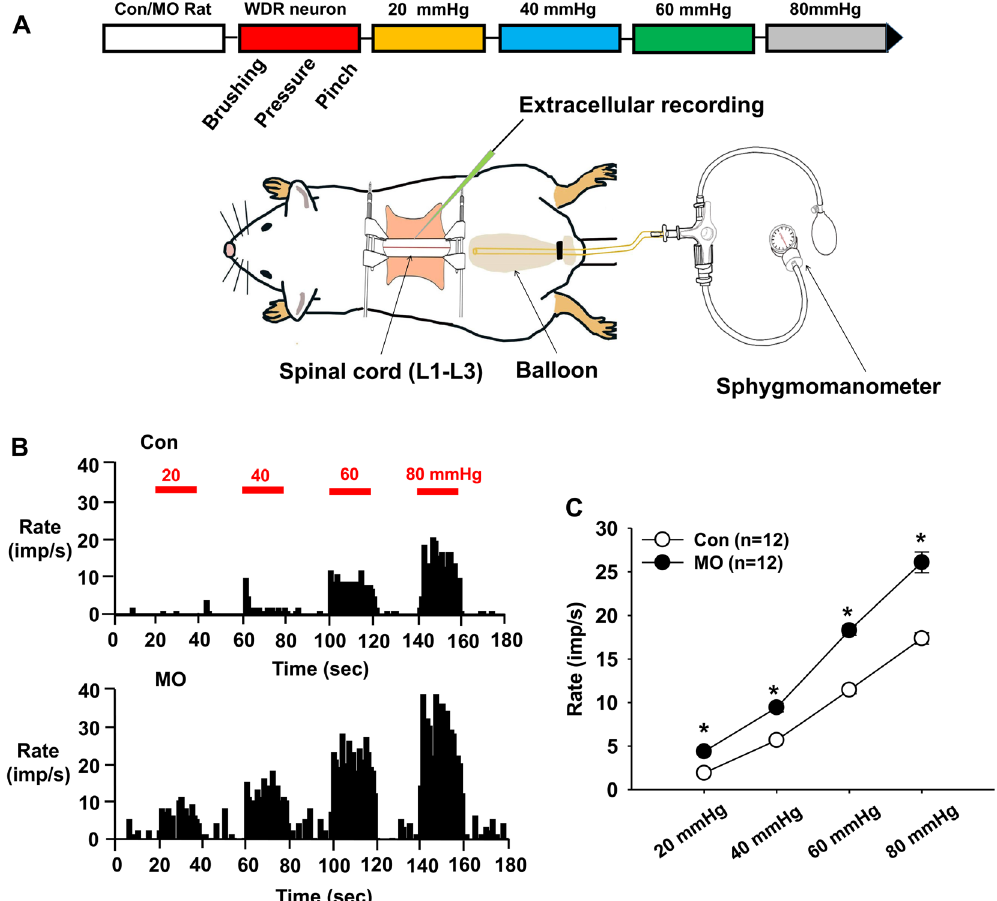
Figure 5. Enhancement of spinal WDR neuronal activities in MO-infused rats. (A ) Experimental schedule (upper) and schematic illustration for extracellular recording in the spinal dorsal horn (lower). ( B,C ) Single-unit activity of WDR neurons in response to CRD in normal (n = 12) or MO-infused rats (n = 12). Representative histograms of neuronal responses to CRD ( B ). Summary of WDR neuronal responses to CRD ( C ). * p < 0.05 vs. Con (control). MO, mustard